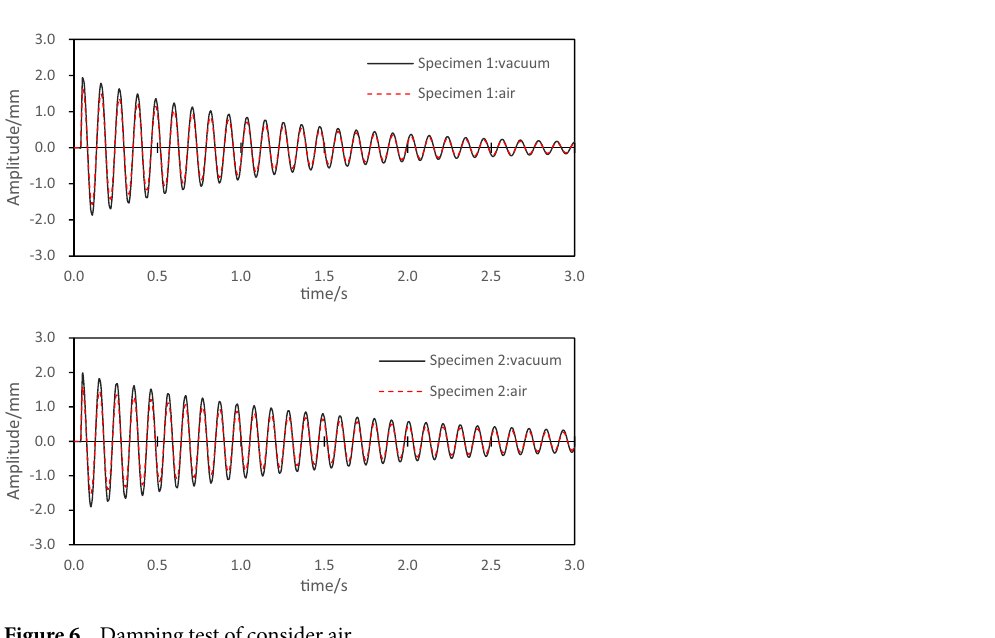
Figure 6. Damping test of consider